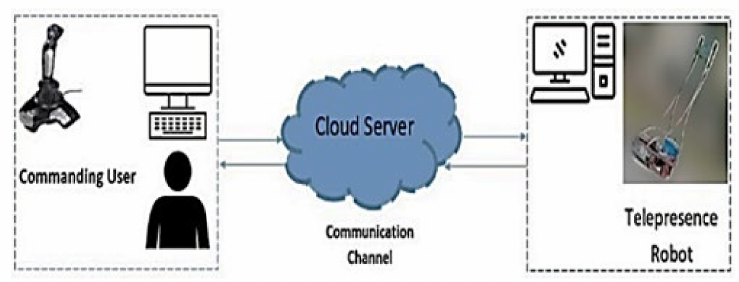
Figure 1. Generalized telepresence robot framework.